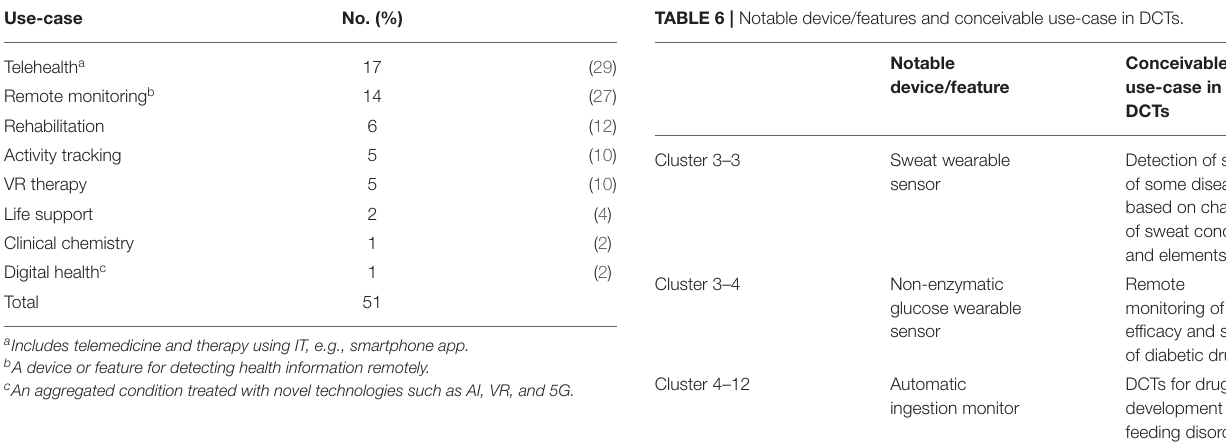
TABLE 4 | Use-case of identified device/feature examples from sub-clusters.